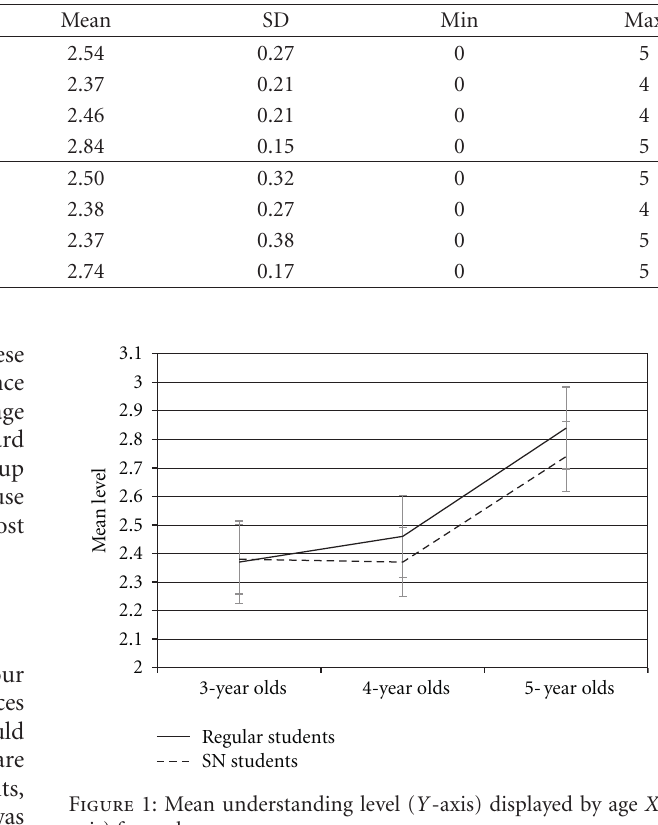
Table 1: Mean, standard deviation, and minimum and maximum levels of understanding per group of students (regular and SN) and cohort.